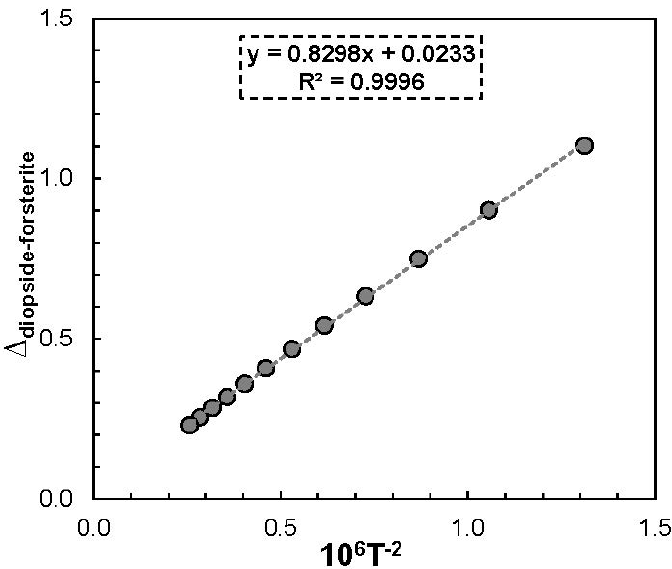
Figure 2. Plot showing linear relationship between inverse square of temperature (10 6 /T 2 ) and oxygen isotopic fractionation between diopside and forsterite ( ∆ Di-Fo ) mineral pair.